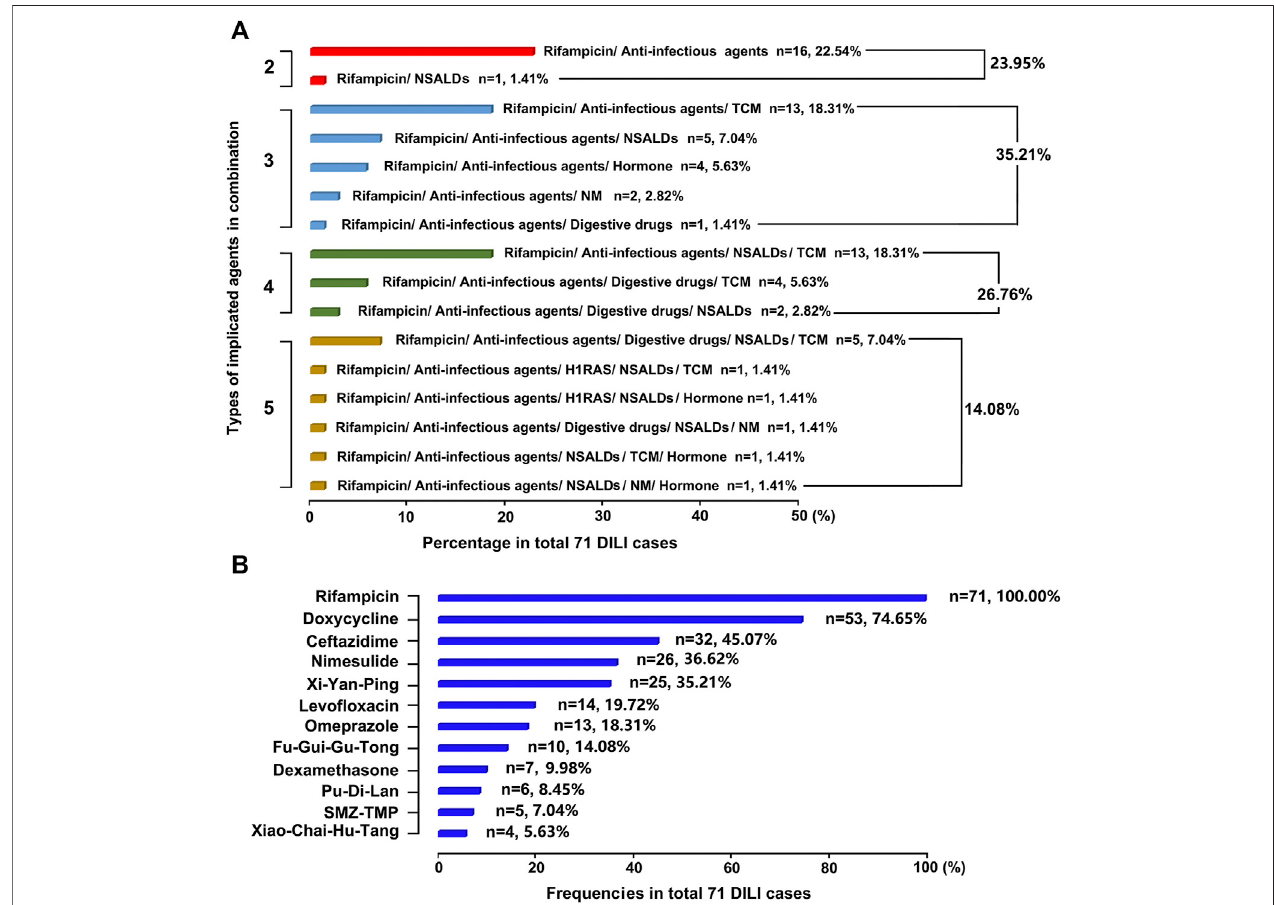
FIGURE3| CausesofDILIinthisstudy (A) Implicated DILIdrugsweredisplayed accordingtotheirtypesincombination (B) Frequenciesofimplicatedspeci fi cDILI drugs were ranked in the total 71 DILI cases.